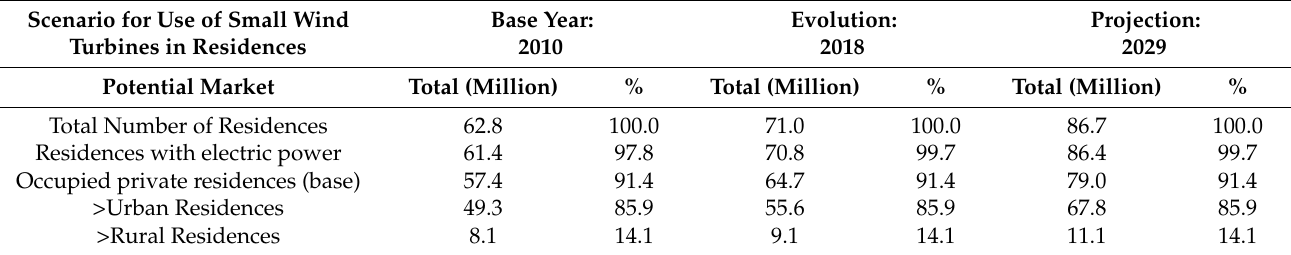
Table 5. Evolution and projection of the number of residences in